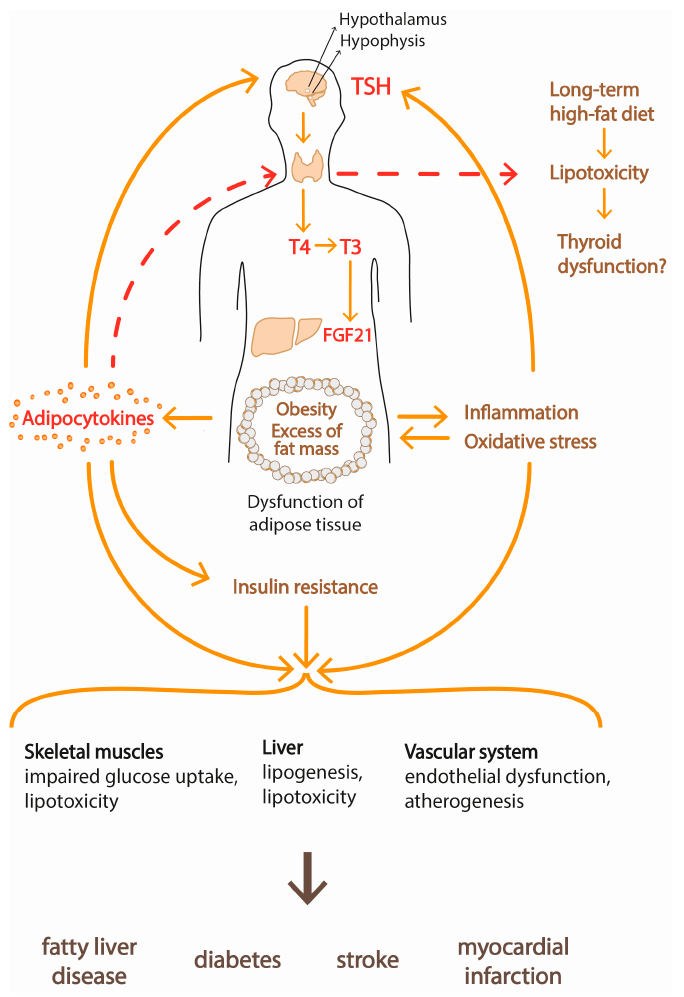
Figure 4. Adipose tissue dysfunction through insulin resistance, altered secretion of adipocytokines and inflammatory state are involved in the development of diabetes mellitus and vascular diseases. The excess of adipose tissue may initiate the lipotoxicity and inflammatory process within the thyroid gland. That leads to the dysfunction of the thyroid gland and results in an energy imbalance. FGF21 is produced mainly by the liver, under T3 control. In the liver, FGF21 increases β -oxidation of fatty acids and downregulates lipogenesis. In WAT, FGF21 stimulates lipolysis and the browning process.